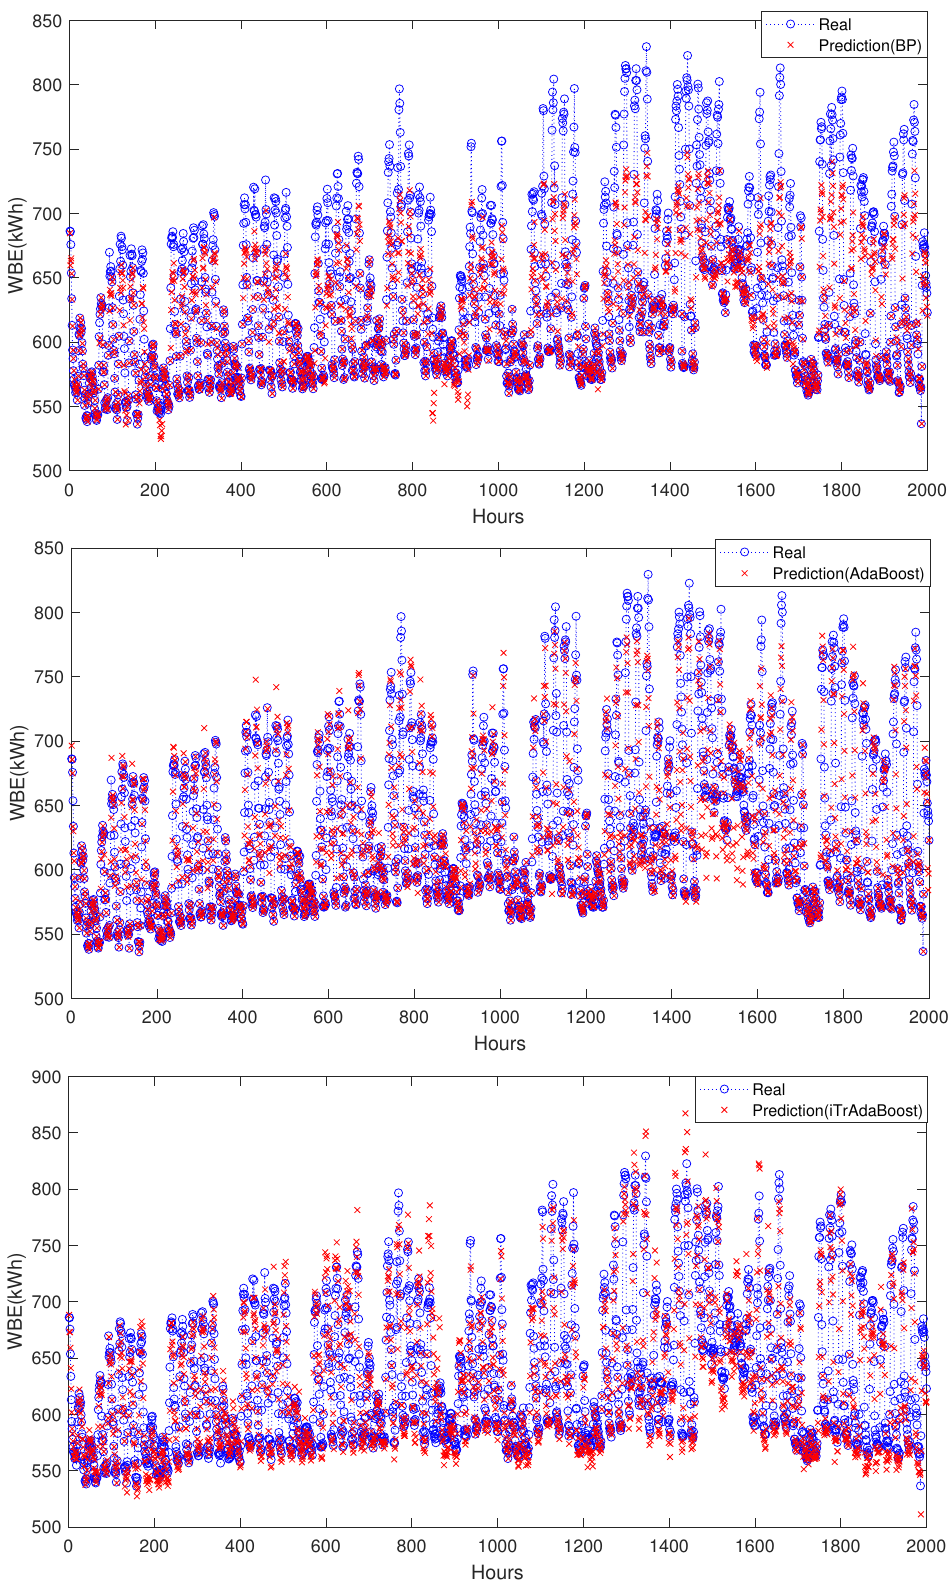
Figure 10. Real and predicted electricity loads using three predictive models, no MMD, 2000 h